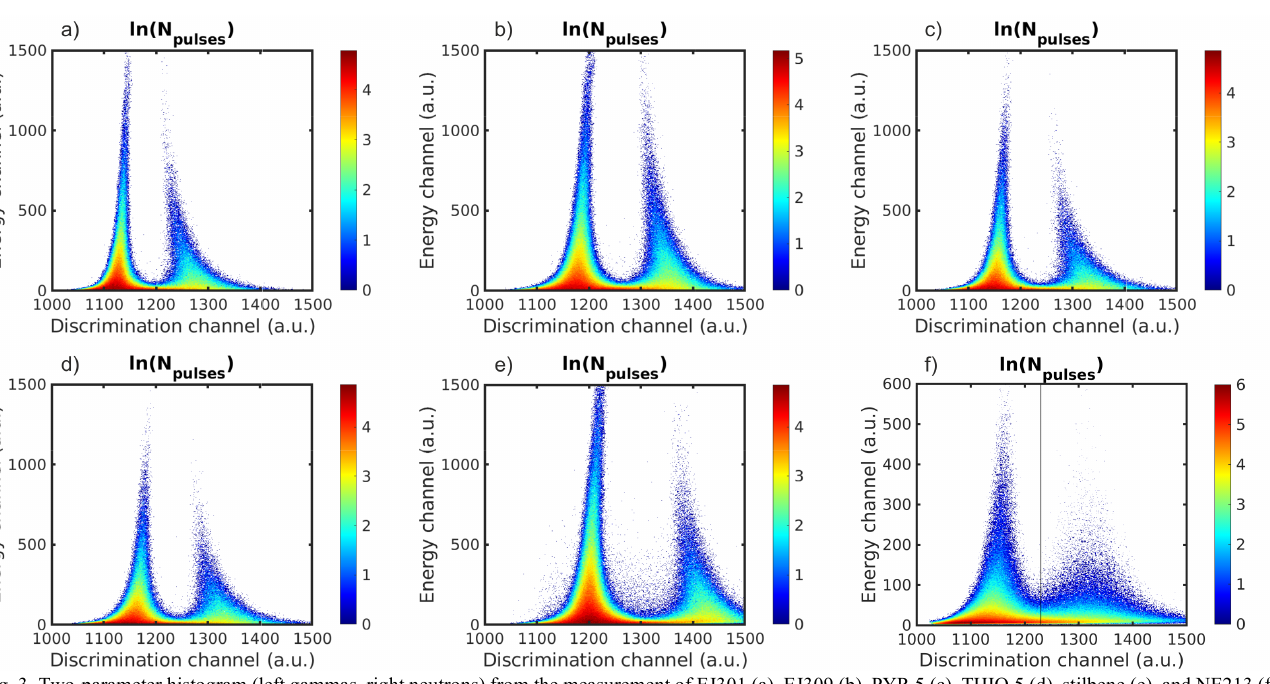
Fig. 3. Two-parameter histogram (left gammas, right neutrons) from the measurement of EJ301 (a), EJ309 (b), PYR 5 (c), THIO 5 (d), stilbene (e), and NE213 (f) using CE of Cs-137; HV of PMT in cases (a-e) was 1650 V, in the case of (f) was 1750 V.